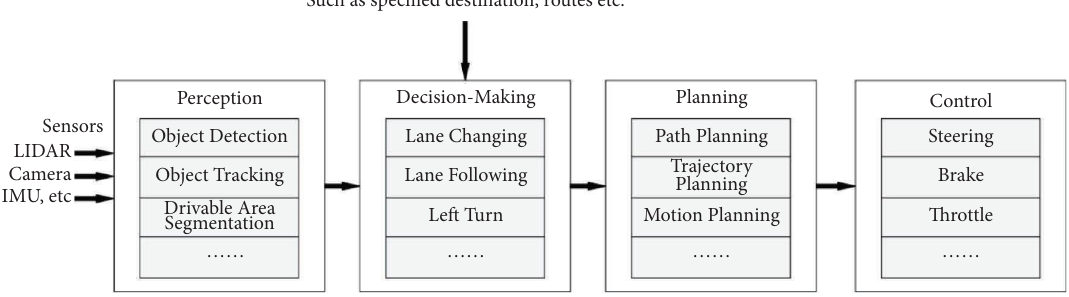
Figure 1: Modular pipeline of autonomous